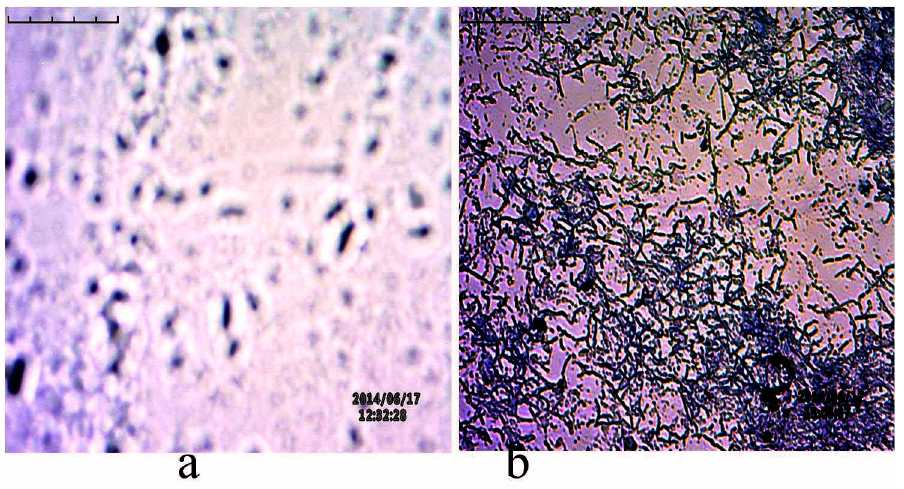
Fig 2. Z-N staining of endo-ovarian tissue biopsy and cultures in the detection of AFB. a) Red/ pink colour rod like beaded structures were observed in the tissue biopsy; b) Red/ pink colour rod like structures were observed on pale blue background in the